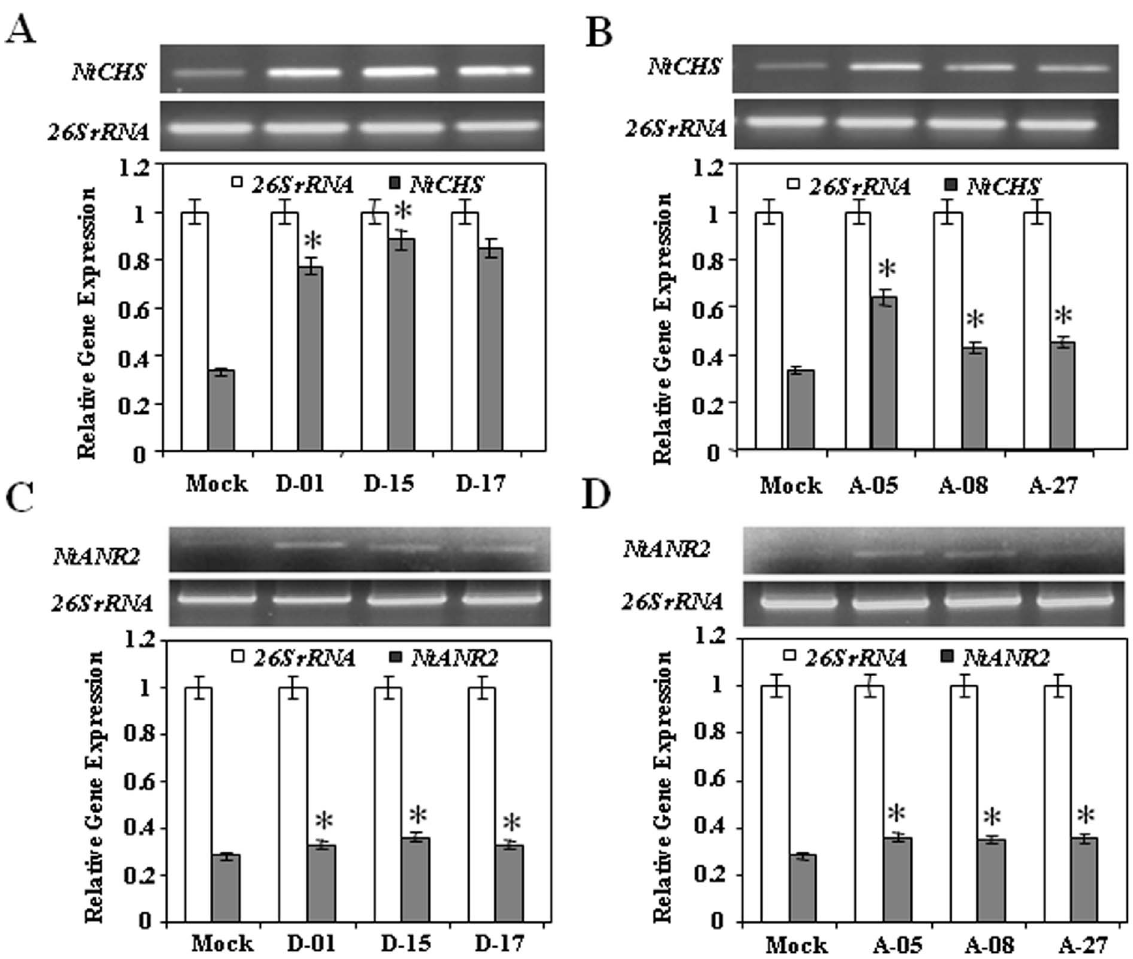
Figure 4. Transcript expression level of NtCHS and NtANR2 gene enhanced in CsDFR and CsANR transgenic tobacco. A, Transcript expression level of NtCHS in CsDFR transgenic lines. B, Transcript expression level of NtCHS in CsANR transgenic lines. C, Transcript expression level of NtANR2 in CsDFR transgenic lines. D, Transcript expression level of NtANR2 in CsANR transgenic lines. Expression of 26S rRNA was used as internal control and experiment was repeated at least three times. Below gel pictures relative level of expression is shown with bar diagram and values are mean of three replications with error bars indicating 6 SD. Statistical significance is indicated as (*) for P , 0.05.